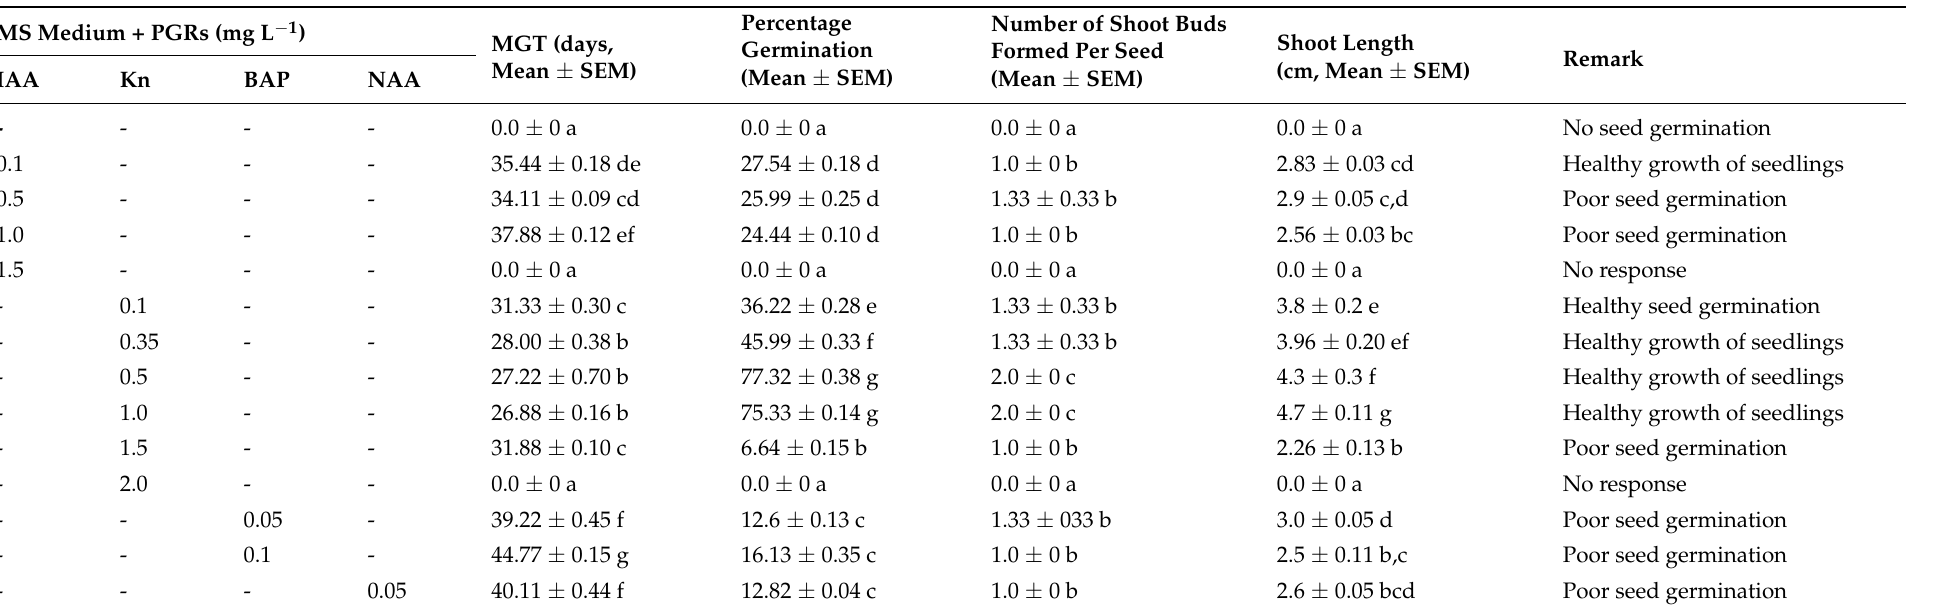
Table 1. Effects of plant growth regulators (IAA, Kn, BAP, and NAA) on direct in vitro seed germination of wild-growing Aconitum violaceum Jacq. ex Stapf. in Ladakh,